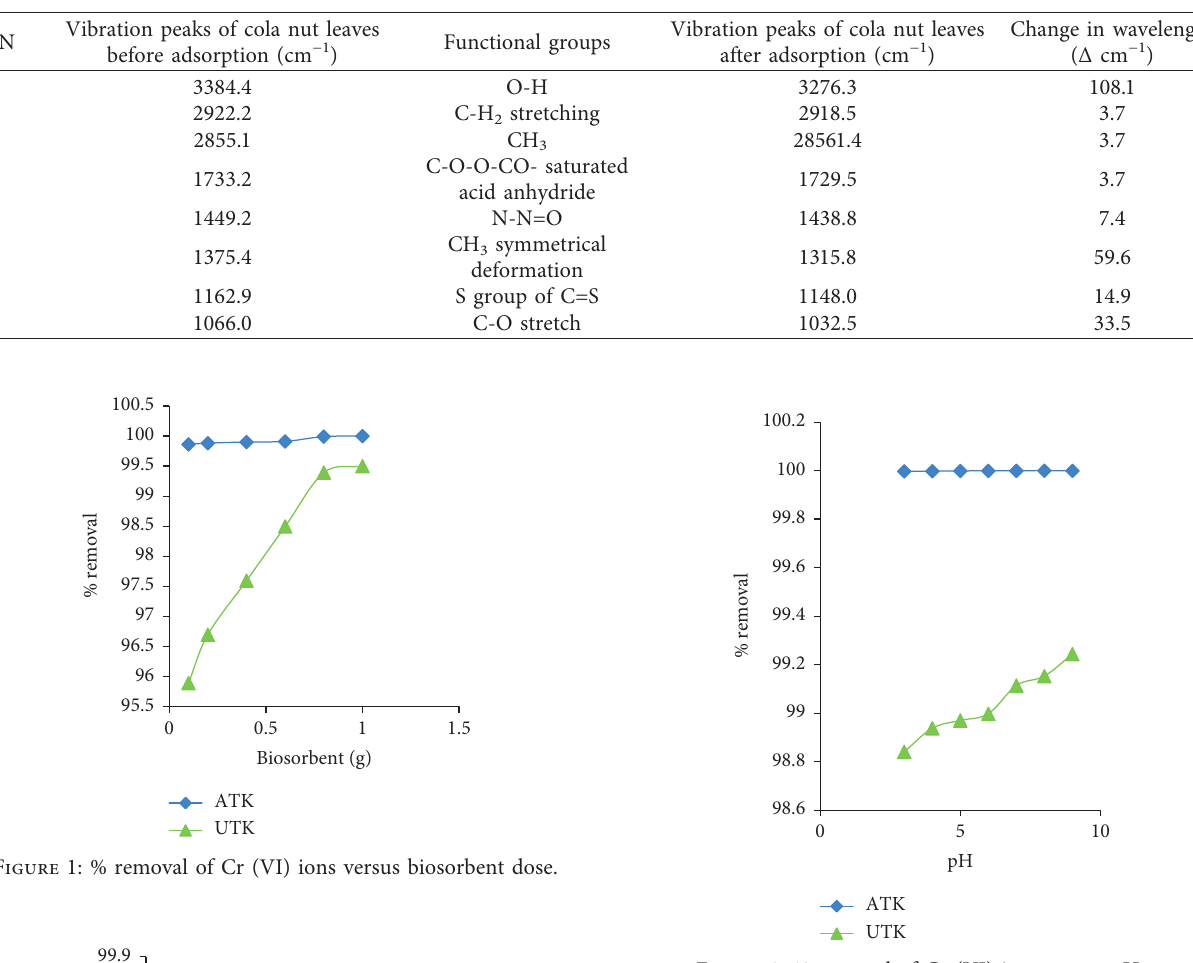
Figure 3: % removal of Cr (VI) ions versus pH.